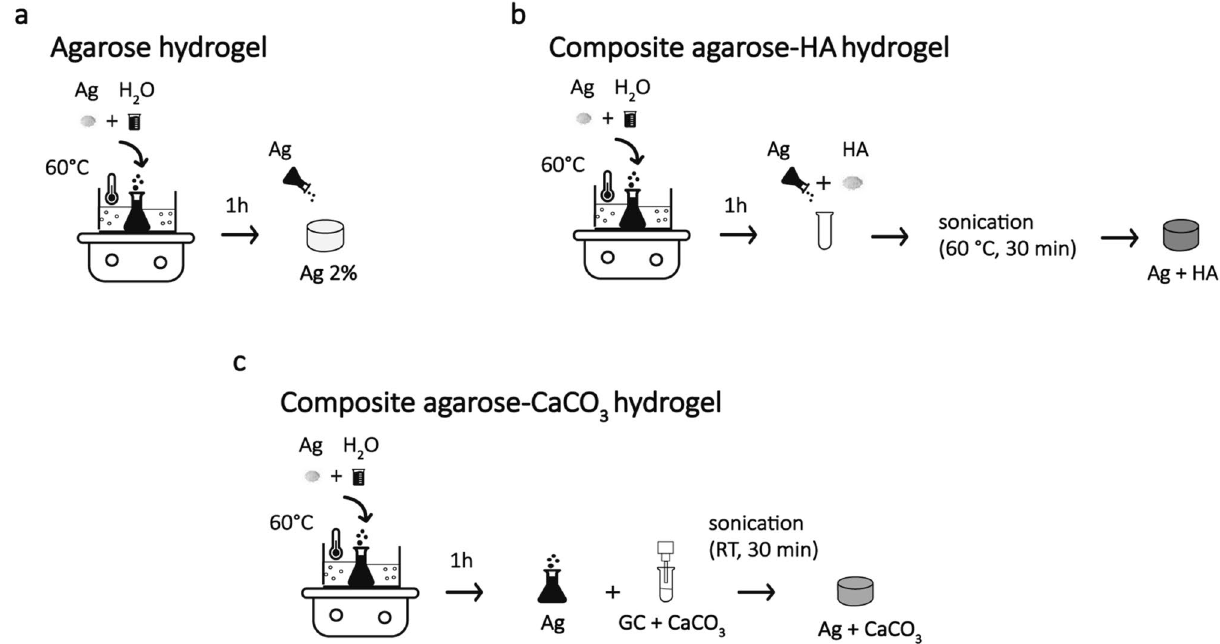
Figure 1. Phantom preparation process. The procedure used for phantom preparation is depicted for agarose hydrogels ( a ), agarose-HA hydrogels ( b ) and agarose-CaCO 3 hydrogels ( c ). Agarose (Ag), Hydroxyapatite (HA), Calcium carbonate (CaCO 3